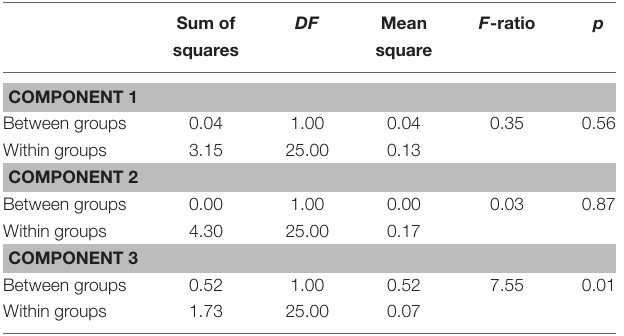
TABLE 2 | Results of analysis of variance. Sum of DF Mean F -ratio p squares